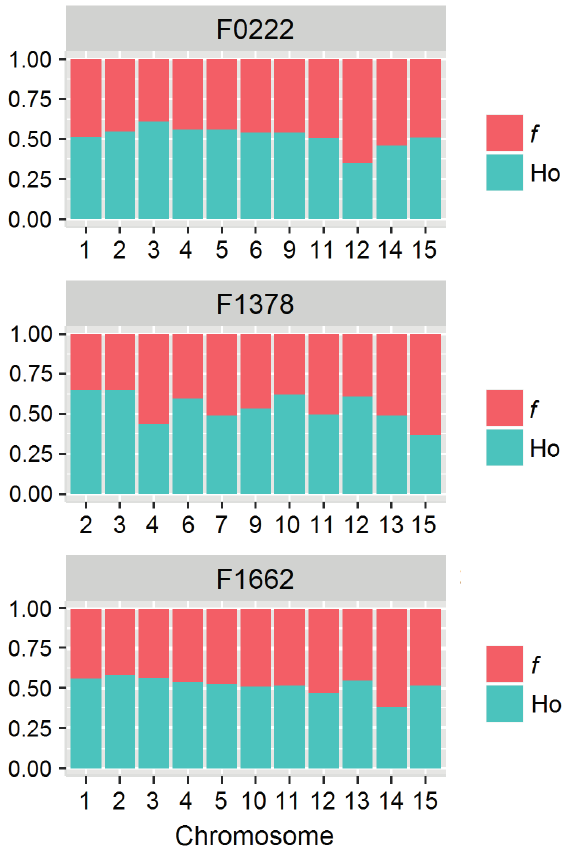
Figure 4 - Distribution of observed heterozygosity (Ho) and inbreeding coefficient ( f ) of the S cassava individuals from the 1 self-pollination of accession BGM0222 (F0222), BGM1378 (F1378) and BGM1662 (F1662), considering the chromosomal location of the molecular markers used for